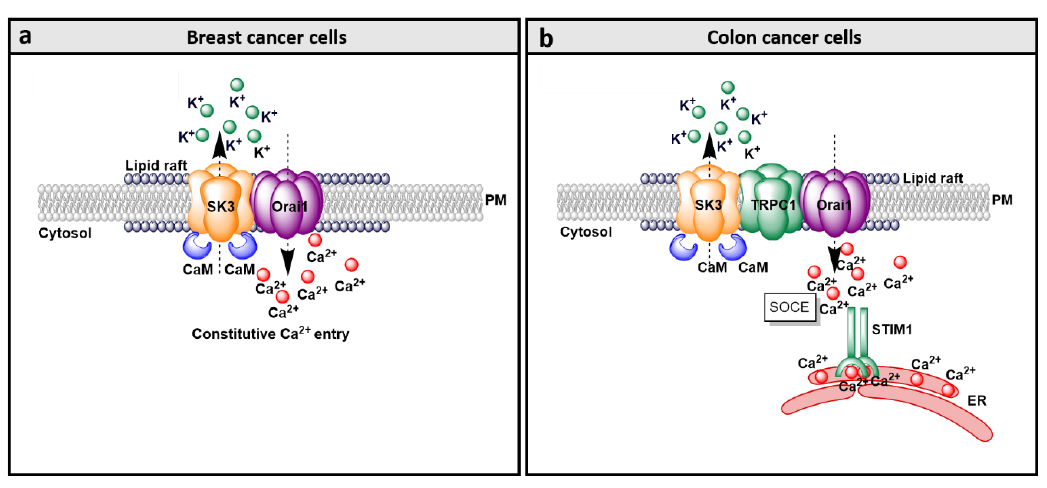
Figure 9. SK3 and Orai1 interplay in different cancer types. ( a ) Colocalized SK3 and Orai1 within lipid rafts exhibit constitutive Orai1-dependent Ca 2 + entry independently of STIM1 in breast cancer cells. ( b ) SK3/TRPC1/Orai1 complex triggers SOCE-dependent cancer cell migration in colon cancer cells.